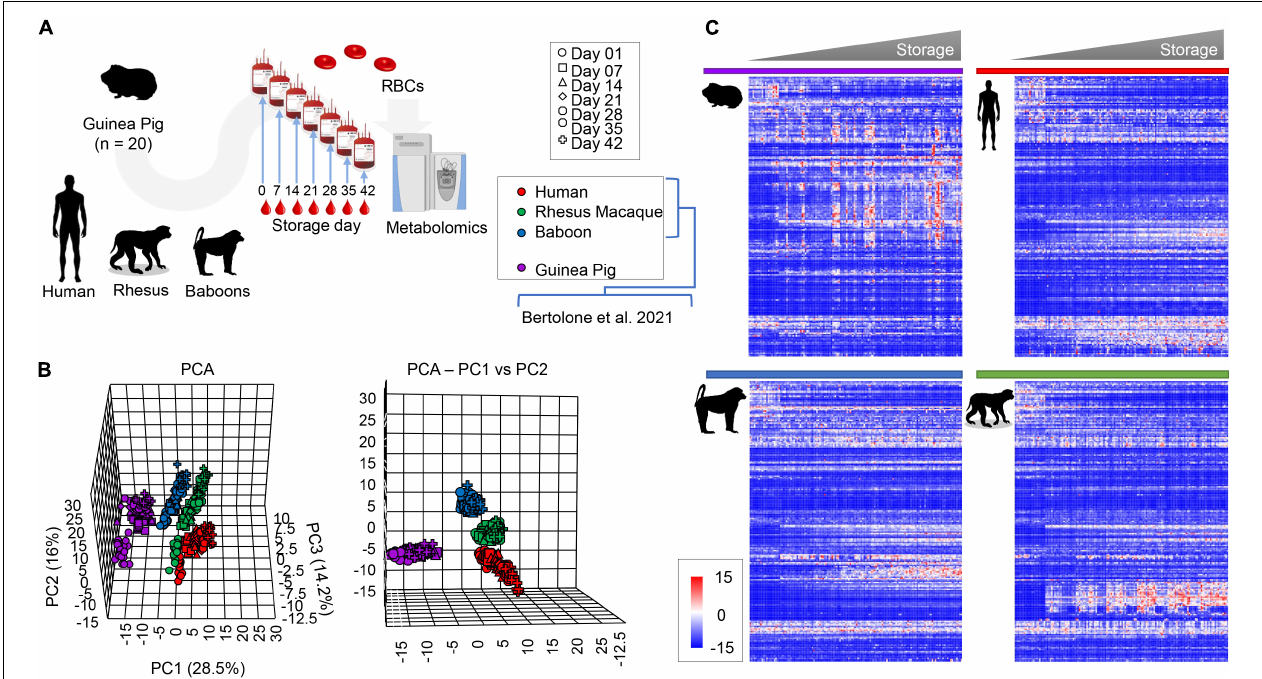
FIGURE 1 | Metabolic phenotypes of stored guinea pig, human, rhesus macaque, and baboon RBCs. Results were determined via high-throughput mass spectrometry-based metabolomics (A) . Multivariate analyses show distinct metabolic phenotypes at baseline and throughout storage, including principal component analysis [ (B) , top and front view] and hierarchical clustering analysis of the significant metabolites by two-way ANOVA [ (C) , time and species].